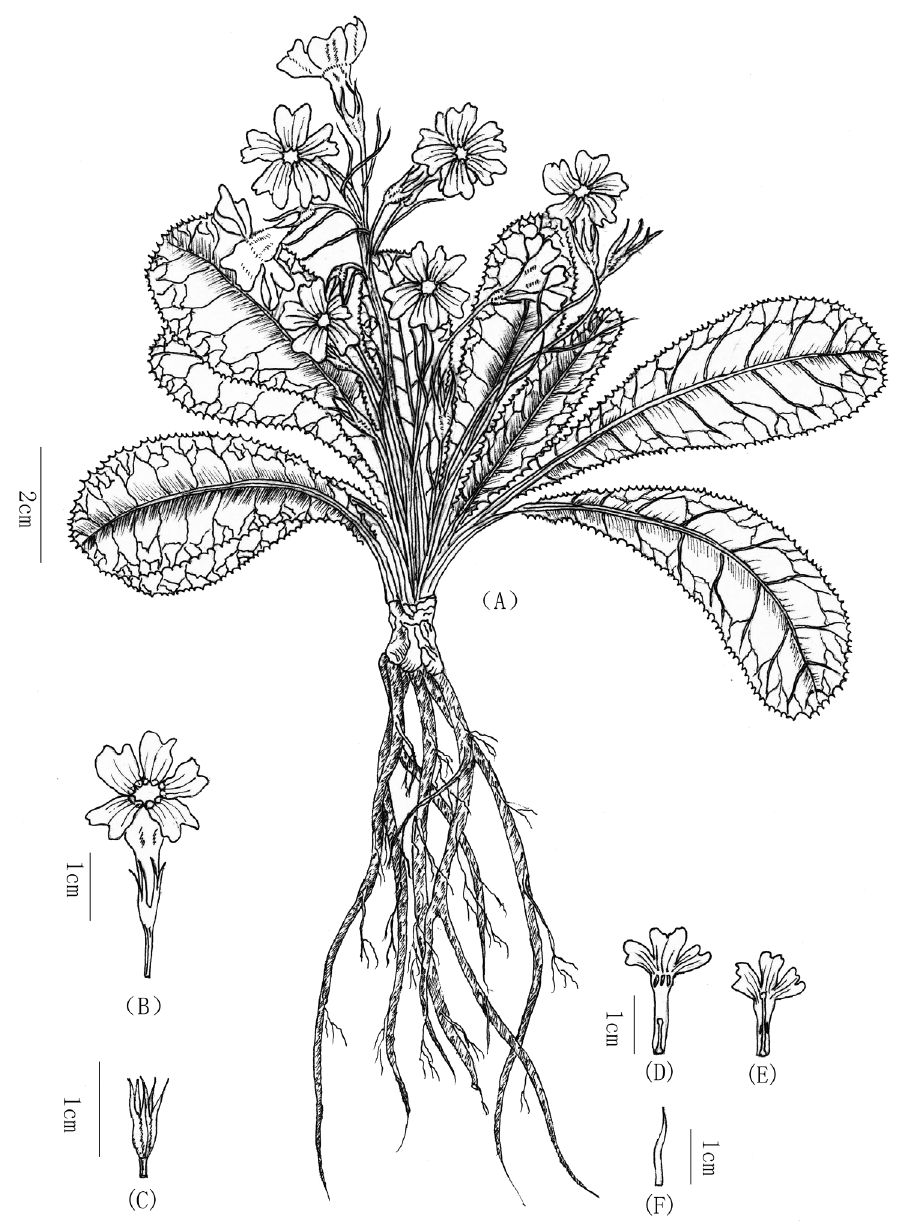
Figure 1. Primula dongchuanensis sp. nov. A Habit B Calyx and corolla C Calyx D Thrum flower E Pin flower F